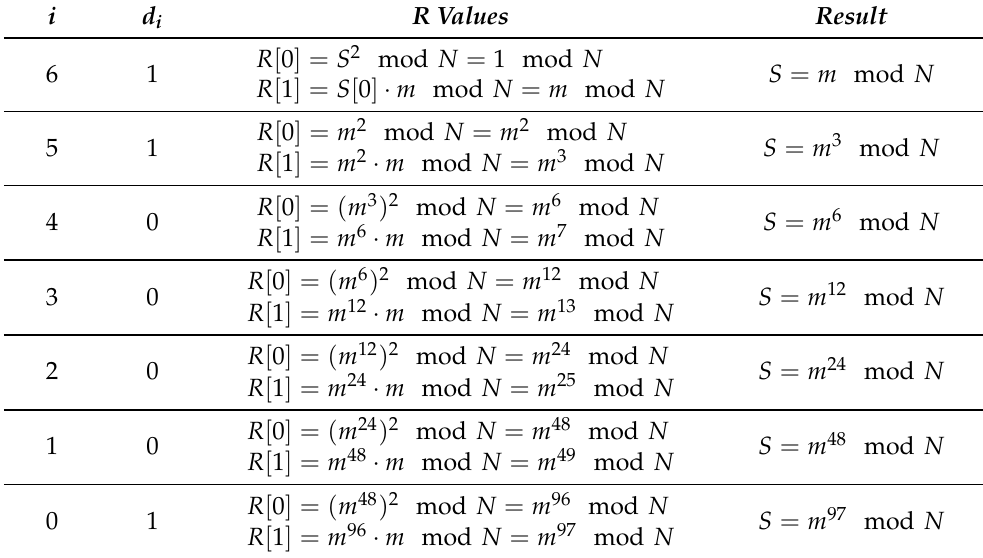
Table 1. Example of the execution of the Algorithm